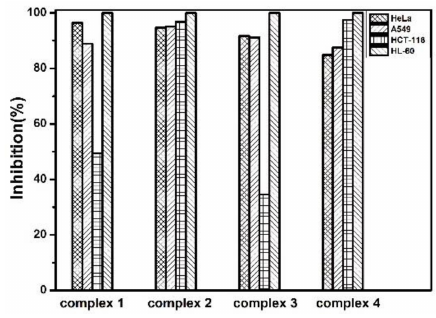
Figure 8. The inhibitory effects of complexes 1 – 4 against four cancer cell lines at the concentration of 50 µ M.